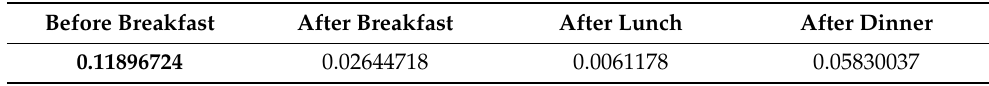
Table A4. Linear Regression Coefficients for model trained on Tags. Before Breakfast After Breakfast After Lunch After Dinner